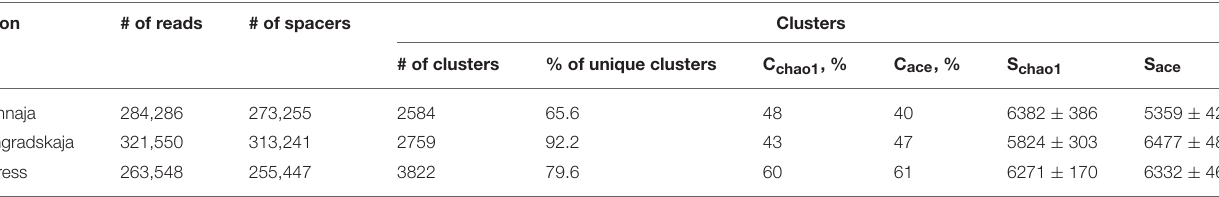
TABLE 3 | Statistics of high-throughput sequencing of PCR amplified Antarctic Flavobacterium psychrophilum CRISPR spacers and spacer clustering results. Station